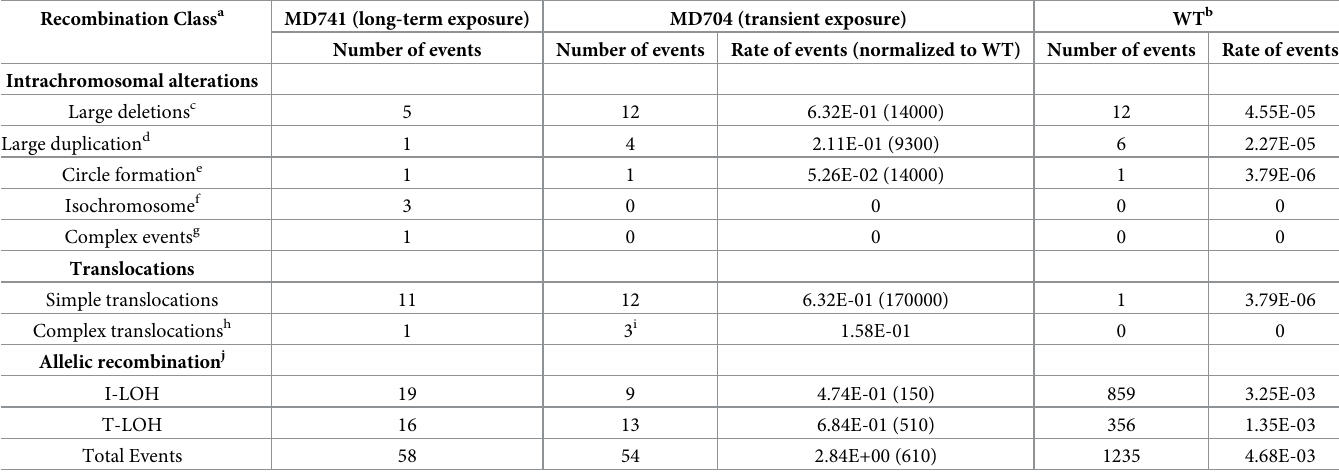
Table 1. Summary of homologous recombination events for diploid strains with long-term and transient CRISPR/Cas9